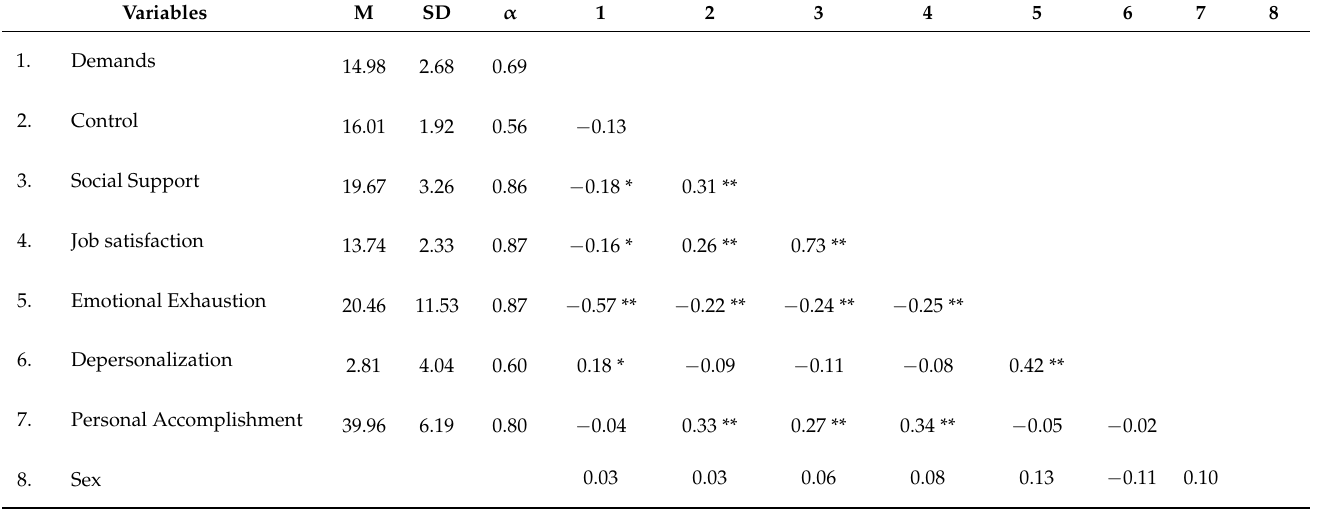
Table 1. Means, standard deviations, and correlations between latent variables.